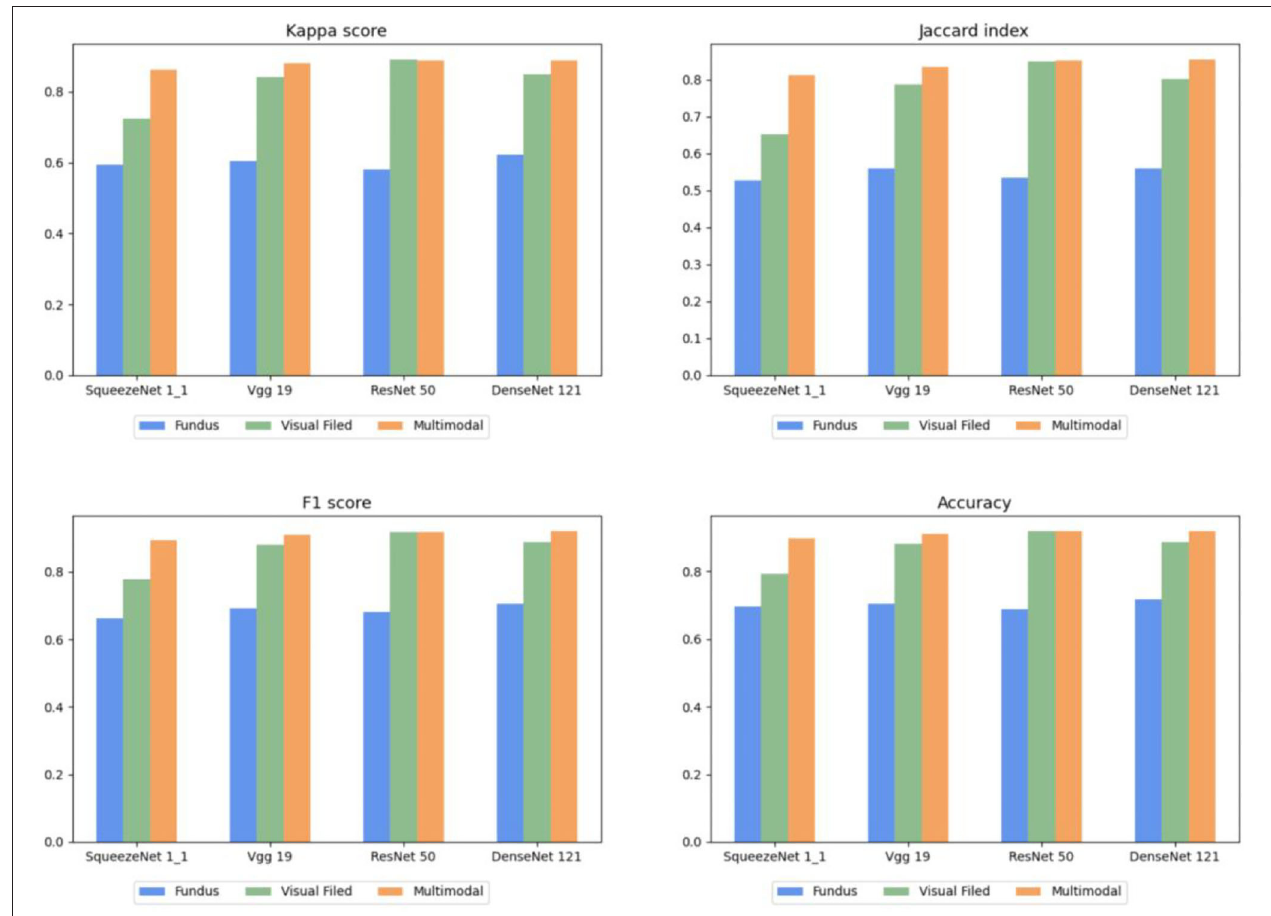
FIGURE 7 | Comparison of multimodal fusion and single path.